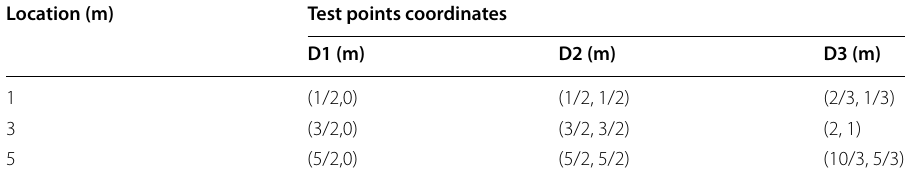
Table 3 Targets location at given